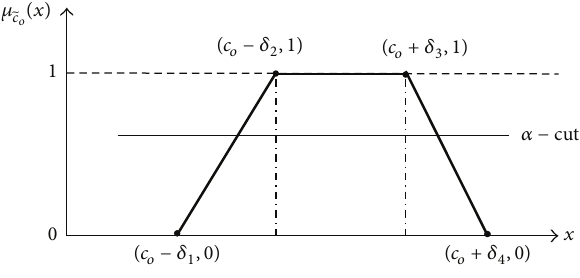
Figure 1: Order cost as a trapezoidal fuzzy